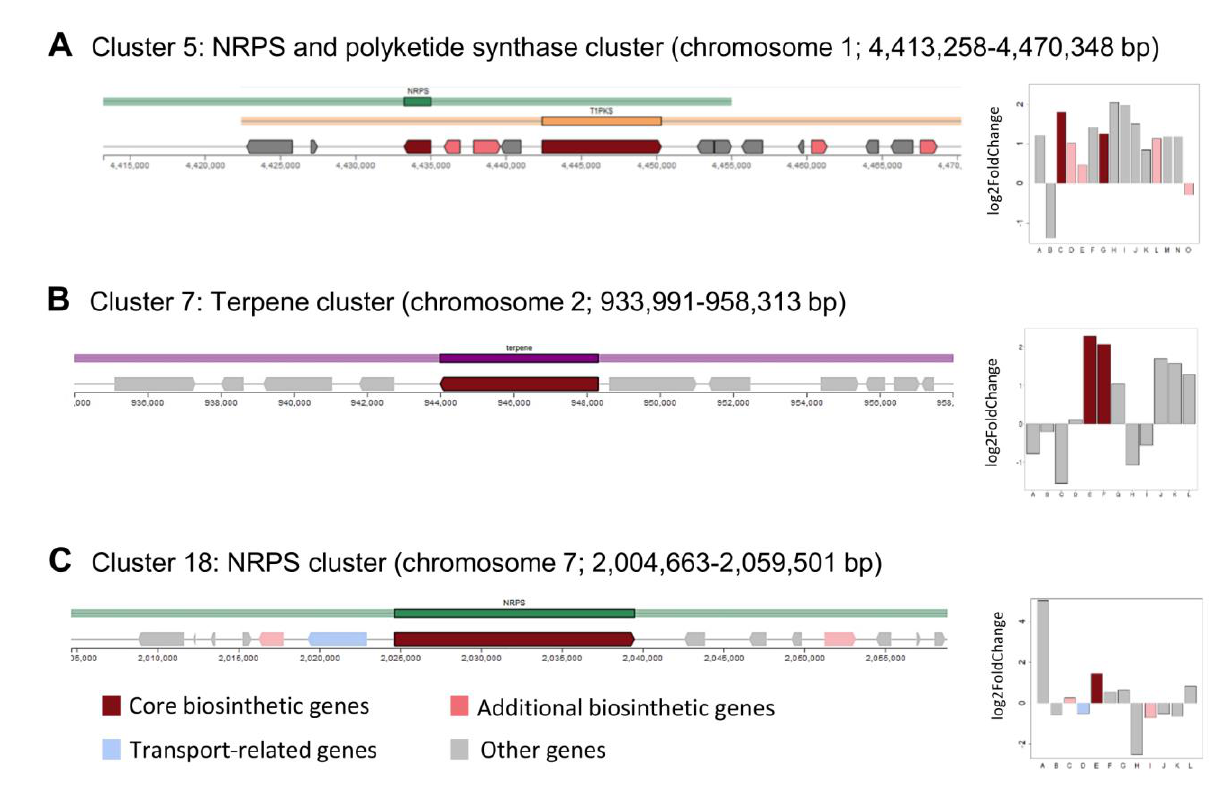
FIGURE 5 : Identification of secondary metabolite clusters in the A. pullulans NBB 7.2.1 genome with the fungal antiSMASH v.5.1.2 online tool [41, 42]. Core biosynthetic genes of three A. pullulans NBB 7.2.1 secondary metabolite clusters were upregulated in response to co- cultuvation with F. oxysporum NRRL 26381/CL57. The core biosynthetic genes (dark red colour) of cluster 5 (NRPS and polyketide synthase cluster) (A) , 7 (terpene cluster) (B) , and 18 (NRPS cluster) (C) were upregulated after one day of interaction with F. oxysporum NRRL